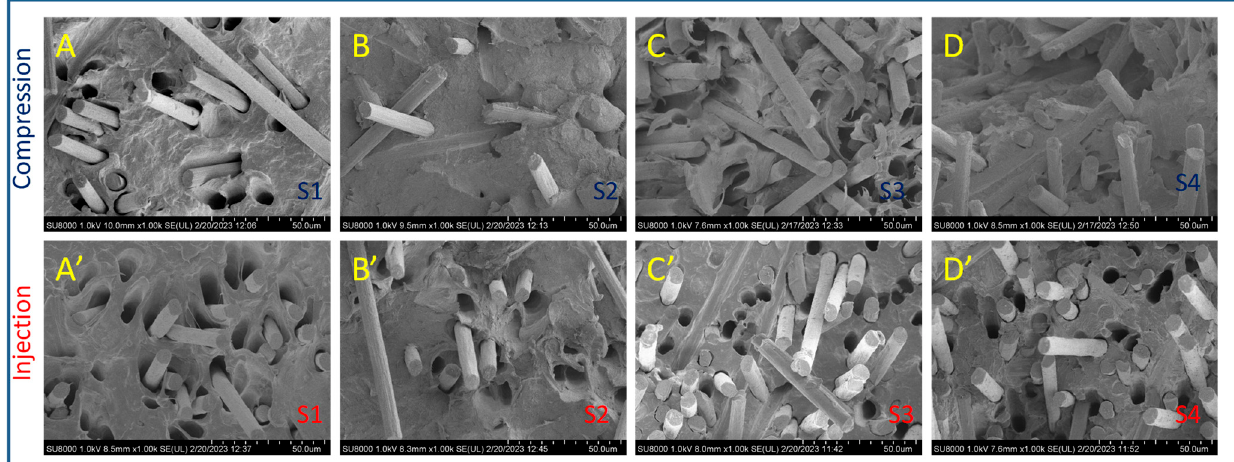
Figure 4. FESEM micrographs of tensile fractured surfaces of the iPP/SCF composites. Up: Compression-molded. Down: Injection-molded.